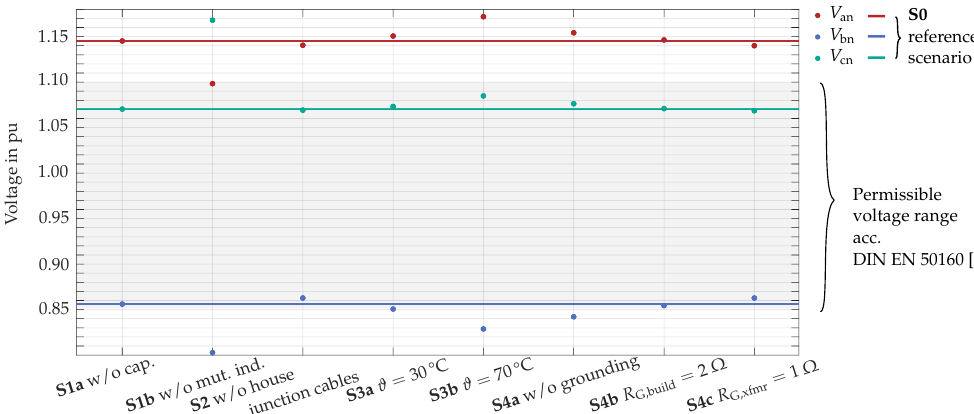
Figure 19. Voltages at node 19 for different model